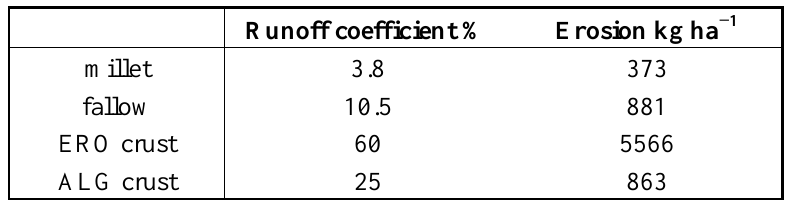
Table 2. Mean runoff coefficient and erosion rates at the plot scale (20 plots, 2004–2008). Data are the average of five years measurement in four plots of 10 m 2 and one plot of 100 m 2 for each